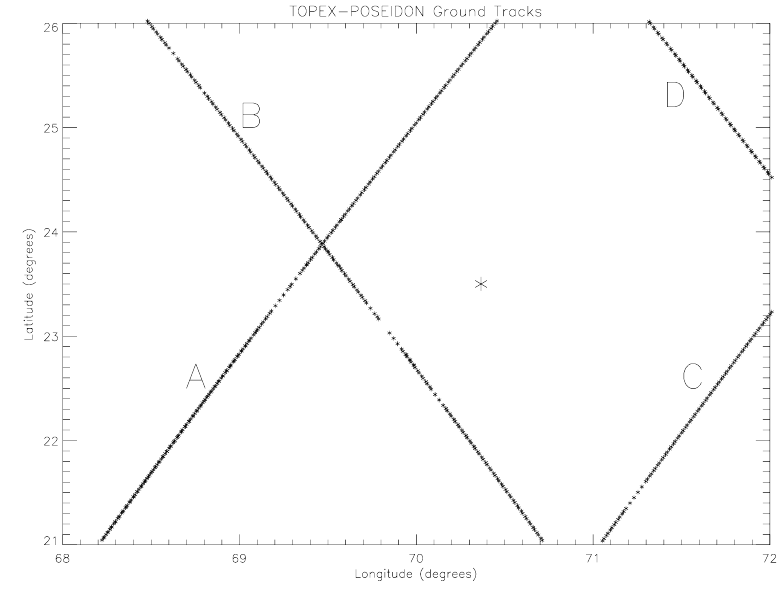
Fig. 1. Orbit tracks of the satellite TOPEX-POSEIDON around the position of the Bhuj earthquake (see also Table 1).